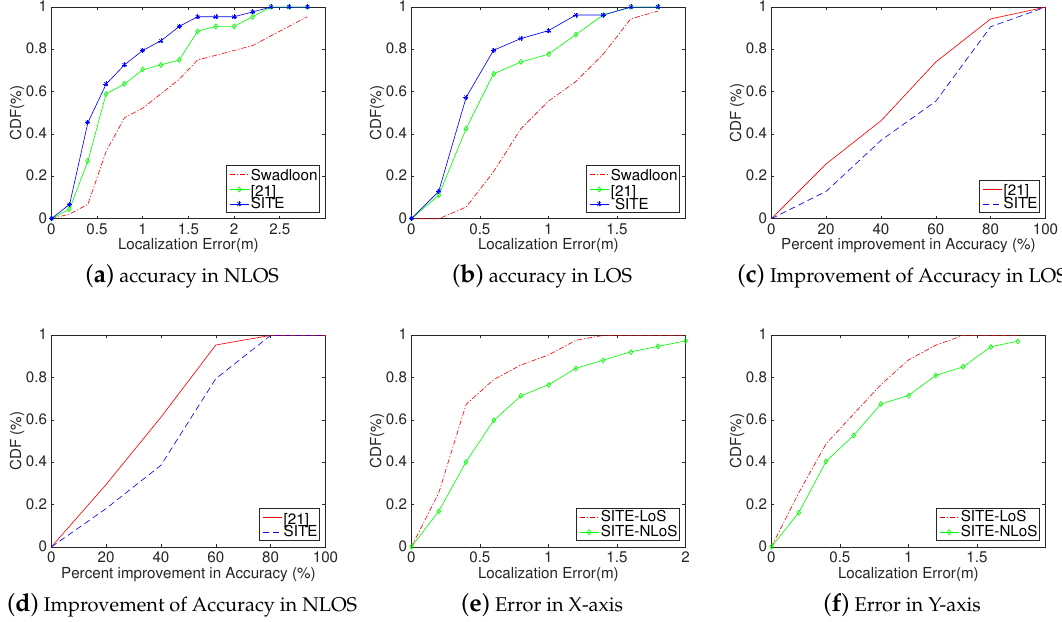
Figure 10. Evaluation Results of SITE , the method in [23] and Swadloon in the Lobby of a building: ( a ) CDFs of localization error in NLOS; ( b ) CDFs of localization error in LOS; ( c ) CDFs of improvement of localization accuracy in LOS; ( d ) CDFs of improvement of localization accuracy in NLOS; ( e ) CDF of localization error in X-axis; and ( f ) CDF of localization error in